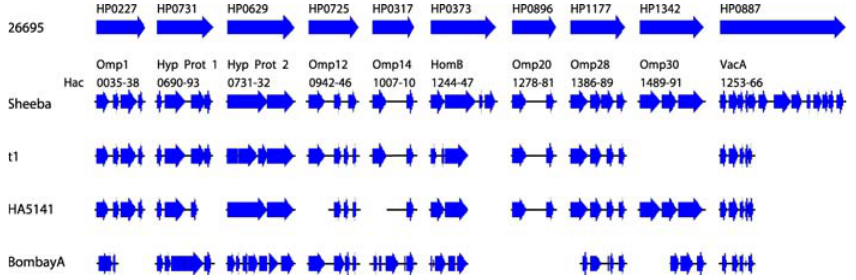
Figure 4. Fragmentation Patterns in Ten Genes among Three H. acinonychis Strains Ten genes that are intact in 26695 but are fragmented in the Sheeba genome (subgroup B) were re-sequenced from strains t1 and HA5141 of subgroup B and BombayA of subgroup A. Black lines indicate sequenced fragments and thick blue arrows indicate CDSs of (cid:2) 140 bp. Designations at the top indicate CDS designations in 26695 whereas designations above the Sheeba sequences indicate both the protein name and the CDS designations in Sheeba (Hac0035, Hac0036, etc.). DOI: